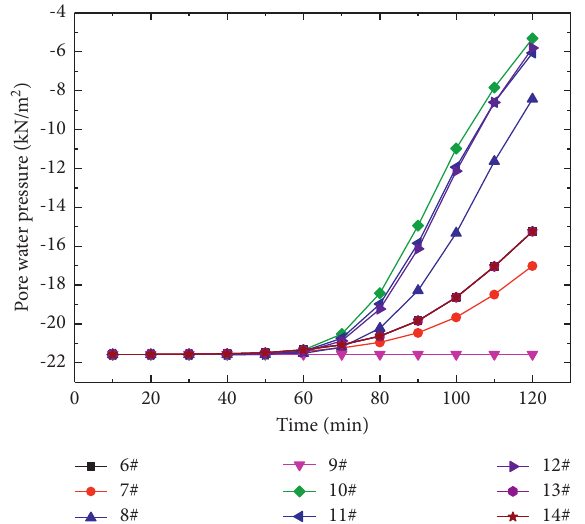
Figure 35: Pore water pressure of observation points 6–14 with seepage wells placed around building 1 in the numerical model.